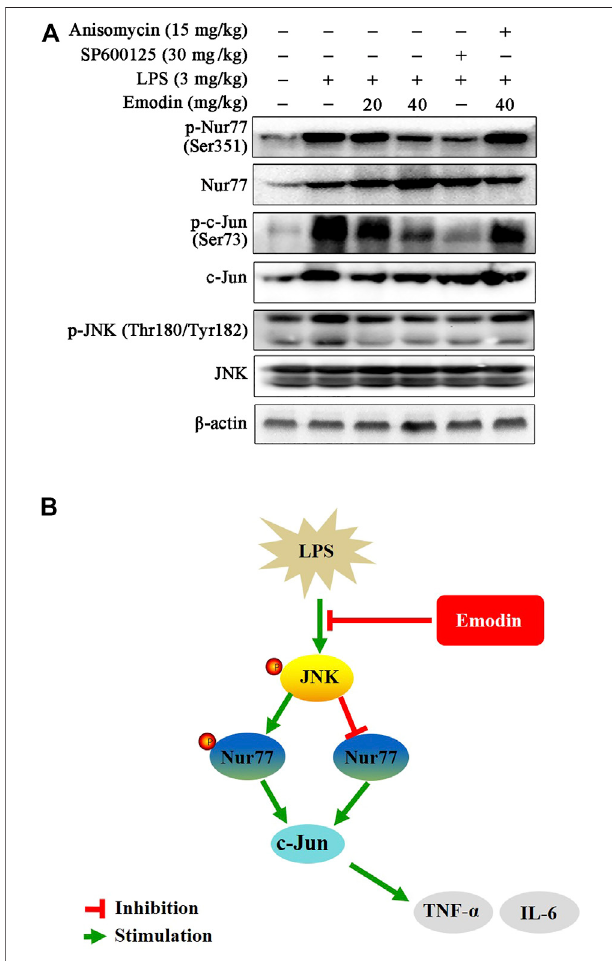
FIGURE 6 | (A) Emodin regulates the Nur77/c-Jun pathway through inhibition of the JNK pathway in LPS-induced acute lung injury mice. The lung tissues were harvested and homogenized. The expression levels of P-Nur77 (Ser351), Nur77, p-c-Jun (Ser73), and c-Jun in total lysates were examined using Western blotting. (B) Illustration of protection provided by emodin on LPS-induced in fl ammation.